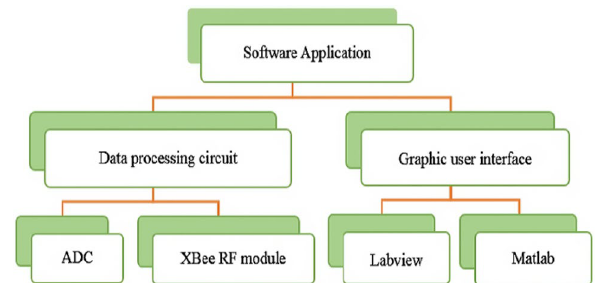
Fig. 6 Block diagram of software